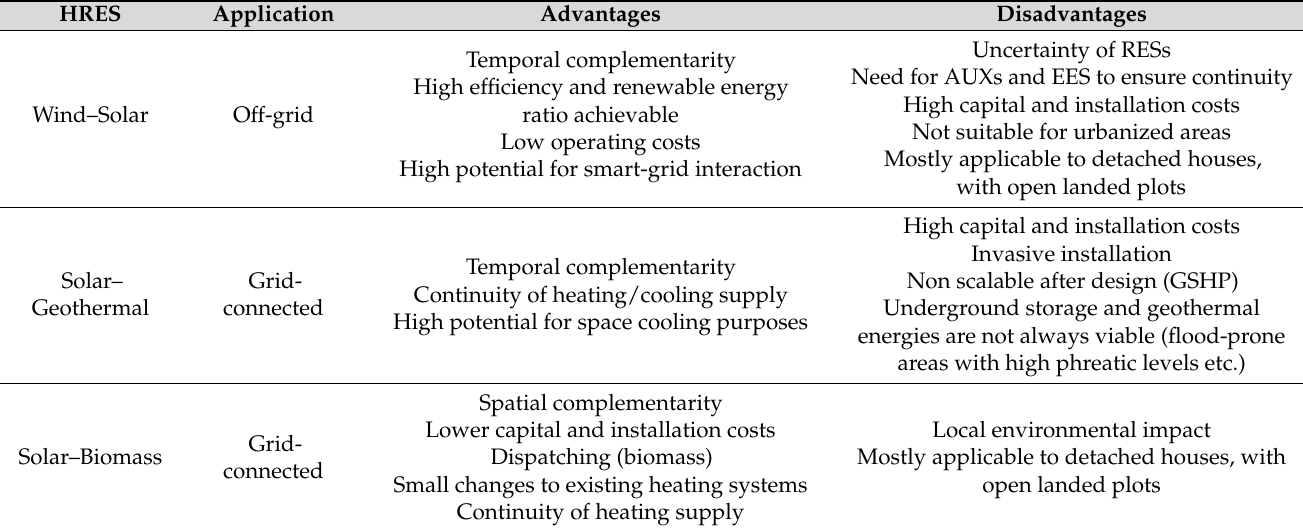
Table 2. HRES solutions applicable to the residential sector together with advantages and disadvantages. HRES Application Advantages Disadvantages